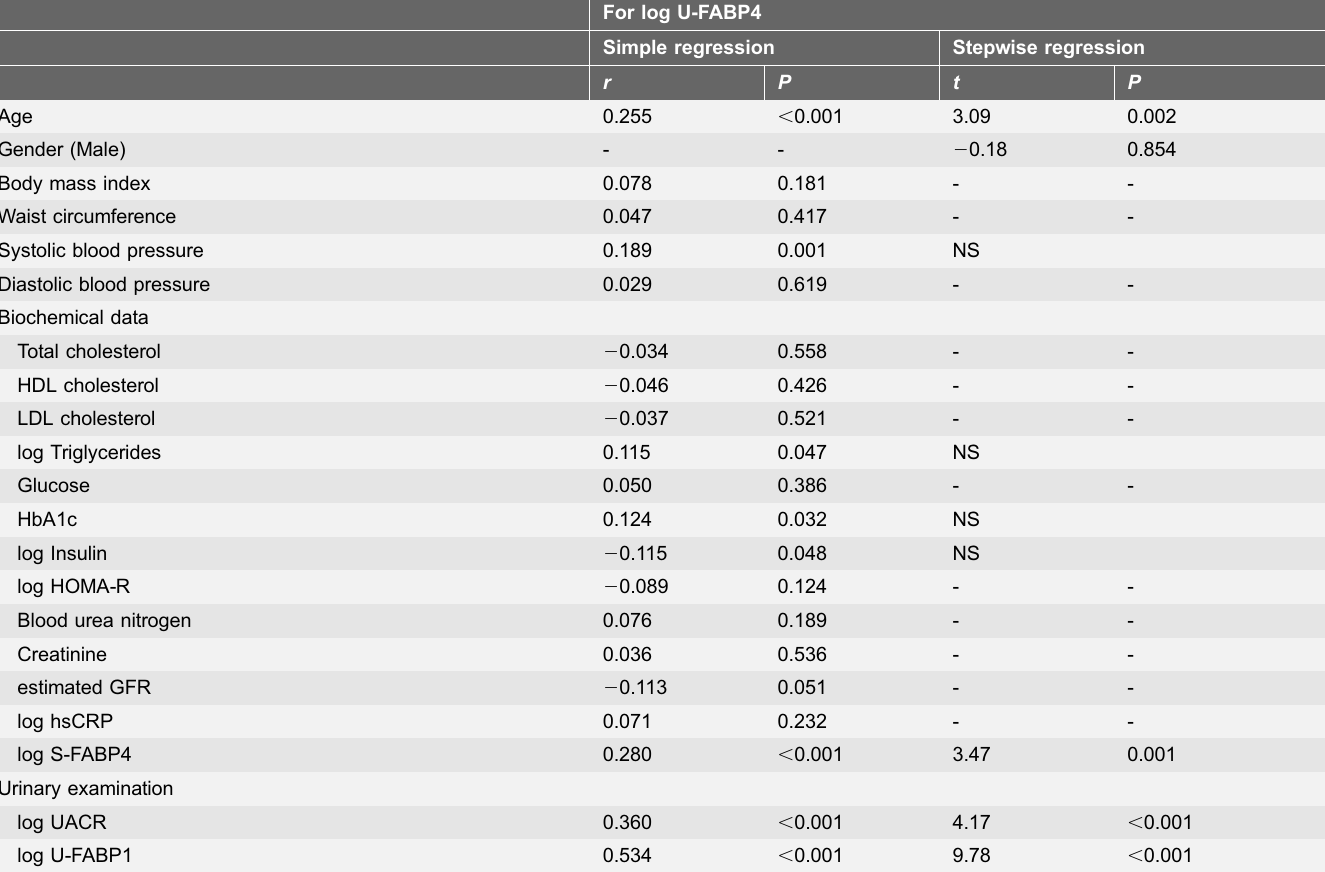
Table 3. Simple and multiple regression analyses for log U-FABP4 (n 5 299).